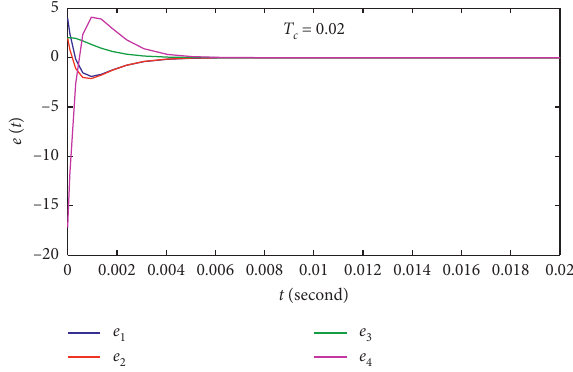
Figure 13: Time response of MFPS error e ( t ) with T � 0 . 2. c